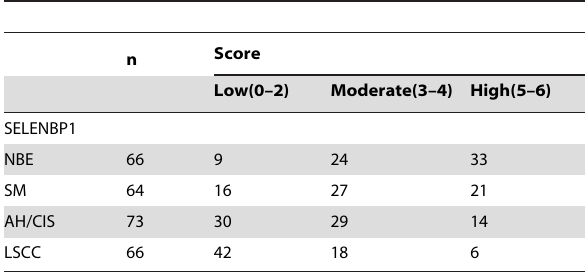
Table 1. The difference of SELENBP1 expression in bronchial epithelial carcinogenic process.